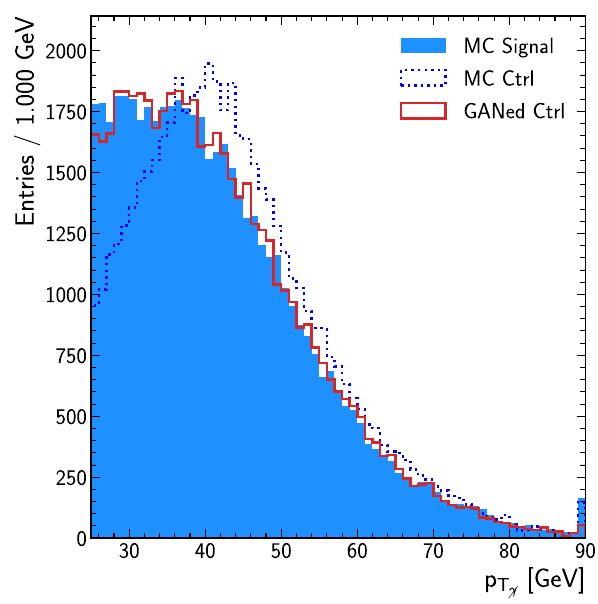
Fig. 5 Distribution of the misidentified photon p T in the MC signal region (MC Signal), MC control region (MC Ctrl) and a misidentified photon generated by the GAN using observables of the events in the the control region (GANed